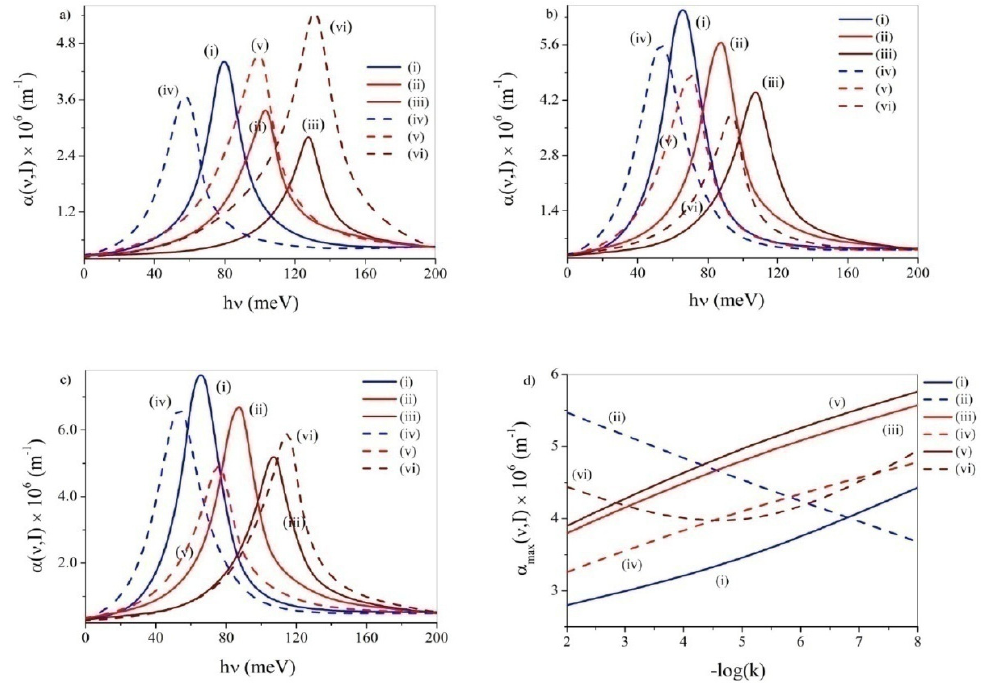
Figure 1. TOAC vs. h υ diagrams: ( a ) devoid of noise, ( b ) under ADWN, and ( c ) under MLWN. In these diagrams the anharmonicity has (i) odd parity and k = 10 − 8 , (ii) odd parity and k = 10 − 5 , (iii) odd parity and k = 10 − 2 , (iv) even parity and k = 10 − 8 , (v) even parity and k = 10 − 5 and (vi) even parity and k = 10 − 2 . (d) Depiction of TOAC peak heights vs. − log(k): (i) devoid of noise and OPA, (ii) devoid of noise and EPA, (iii) with ADWN and OPA, (iv) with ADWN and EPA, (v) with MLWN and OPA and (vi) with MLWN and